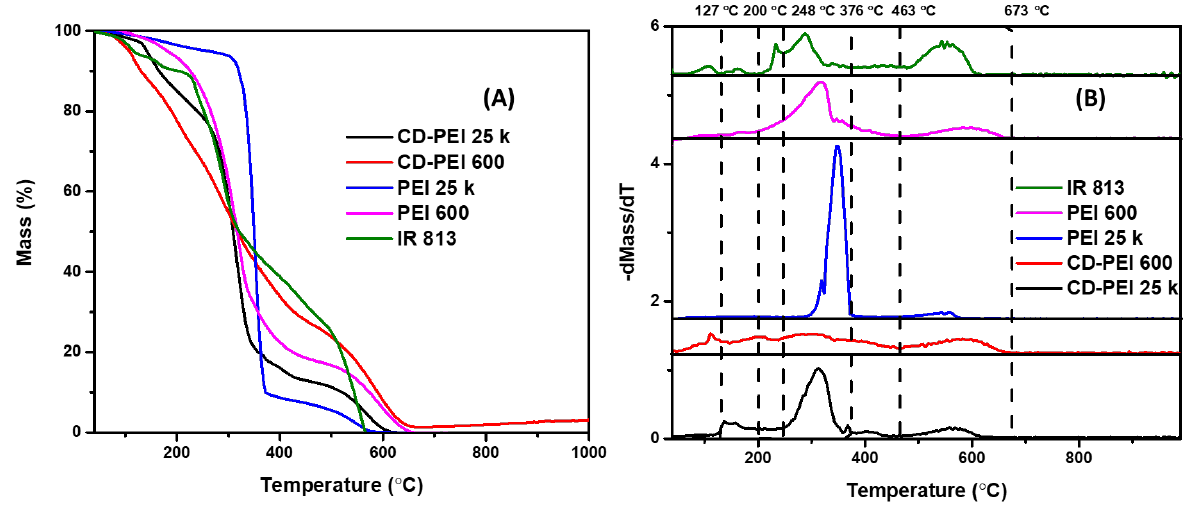
Figure 6. TGA ( A ) and DTG ( B ) of CDs and precursors including IR-813, PEI 600 and 25K. Preliminary consideration of the structure should be based on both TGA and FT-IR data. As shown by TGA data, the aromatics domains represent a relevant amount of both 813-CDs produced by using both PEI 600 and 25 K, and they are due to native aromatic moieties of carbon dots and piperazine-like structure formed during the degradation of PEI [75]. Additionally, IR analysis shows the signal of sulphate proving the persistence of tosyl residues inside the 813-CDs.